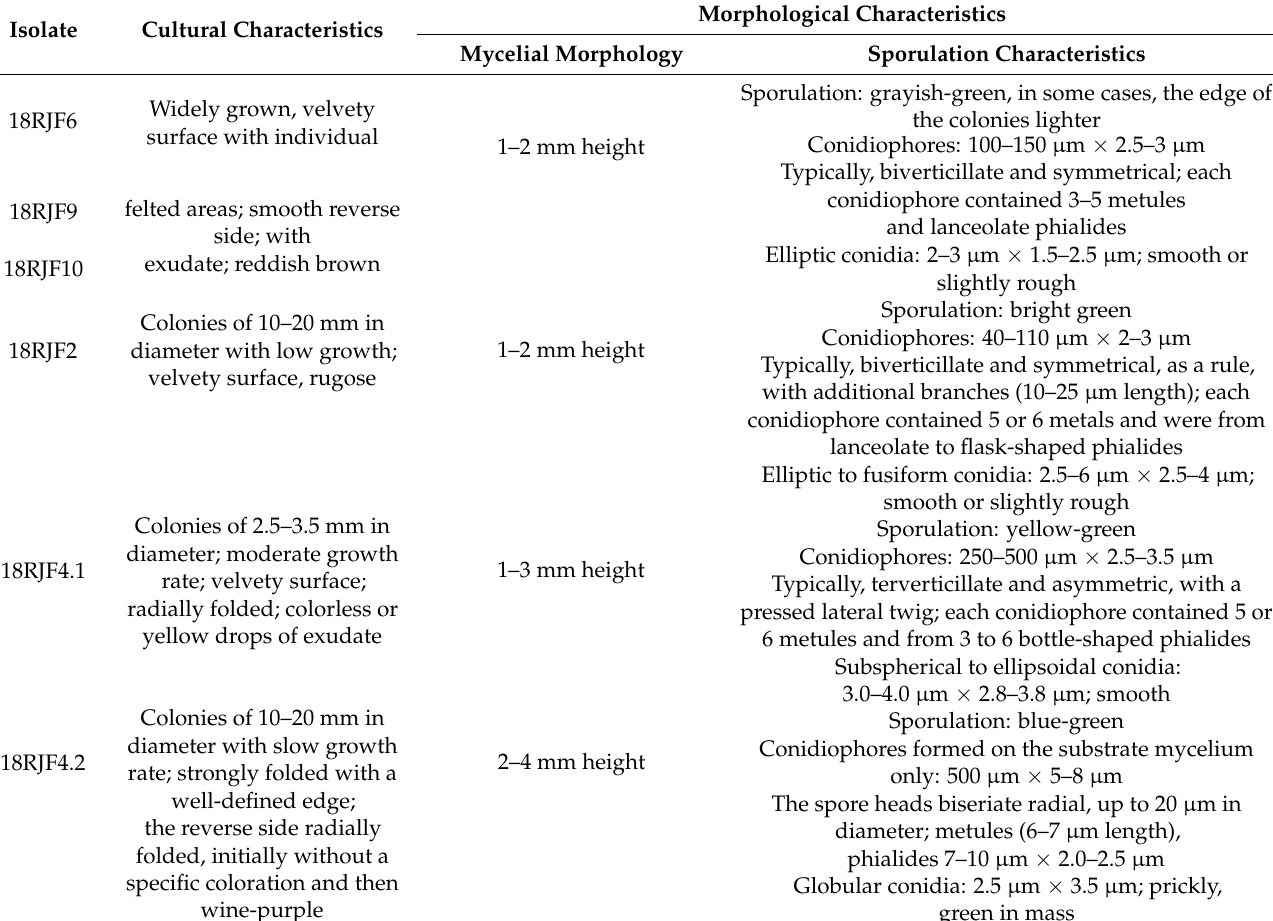
Table 1. Cultural and morphological characteristic of isolated micromycetes.